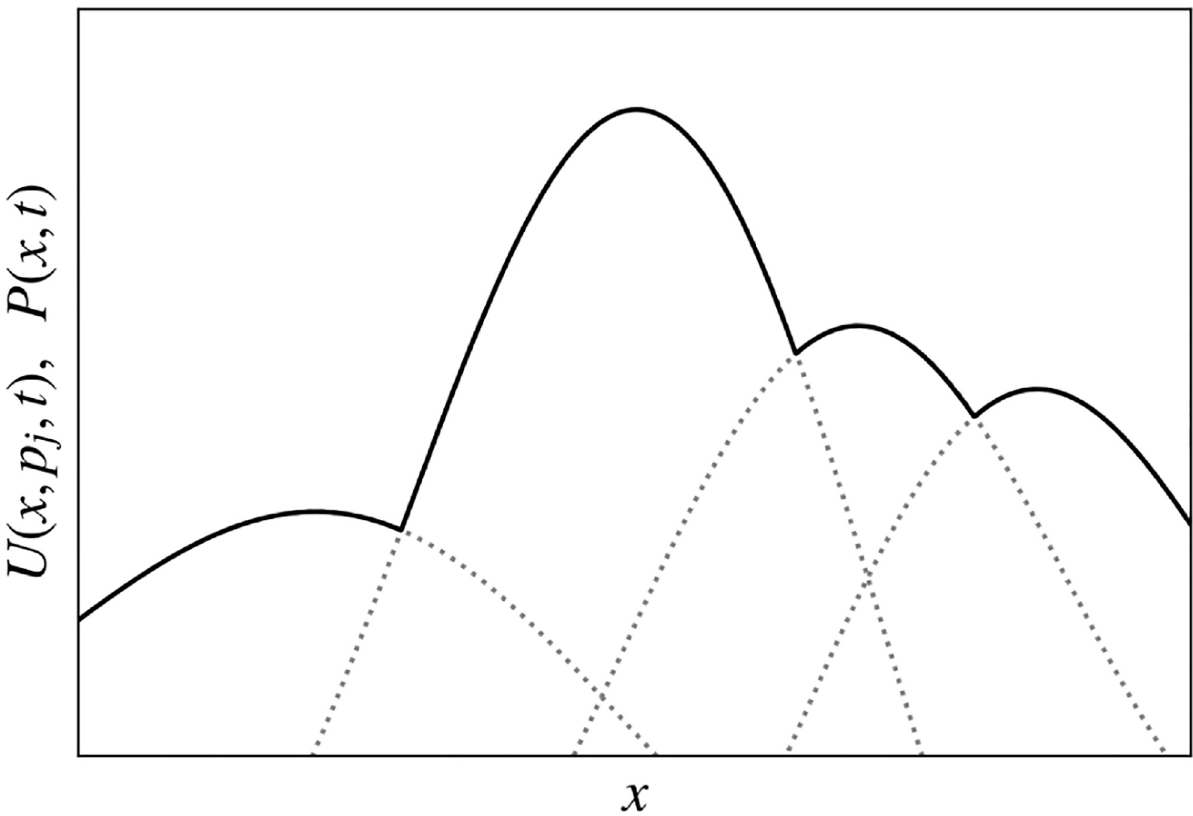
Fig 5. Schematic of how the utility functions of many households (dotted parabolas) determine the price function P ( x , t ) (solid curve), which is the upper bound of U ( x , p , t ) over all p at time t . j